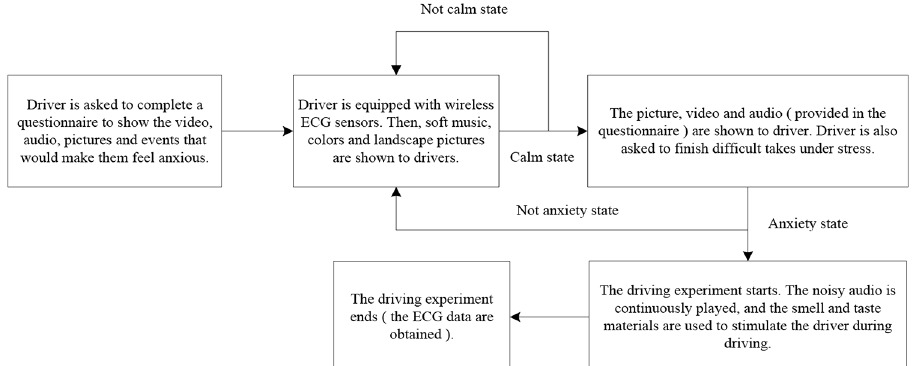
Figure 9 The experimental process of real driving and driving simulations in